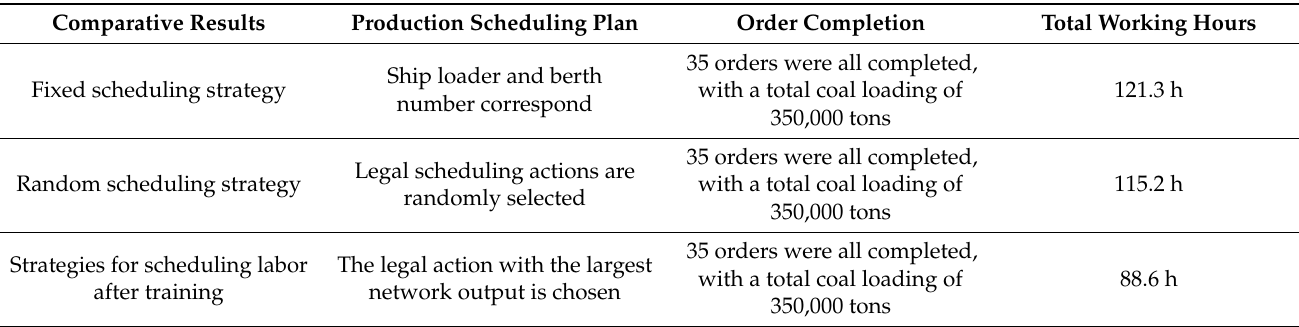
Table 4. Comparison of scheduling results of loading and platooning.